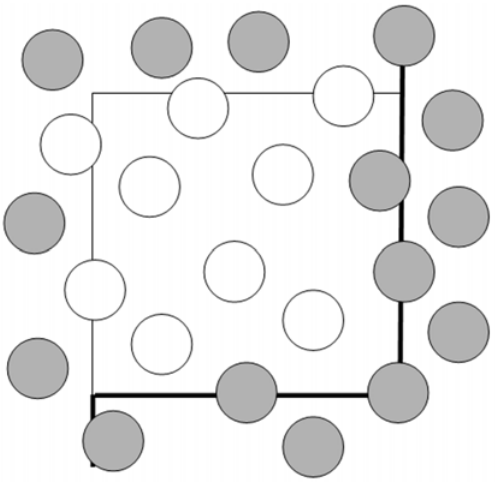
Fig. 13 – Test frame for profile counting: thicker line represents ‘‘forbidden line’’ (all structures hitting this line are not consid- ered). In the schema only white circles are counted (based on Gundersen